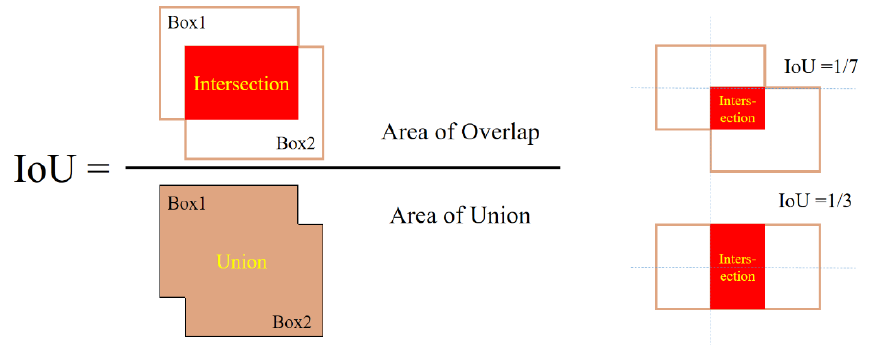
Figure 11. Schematic diagram of the calculation of IoU.